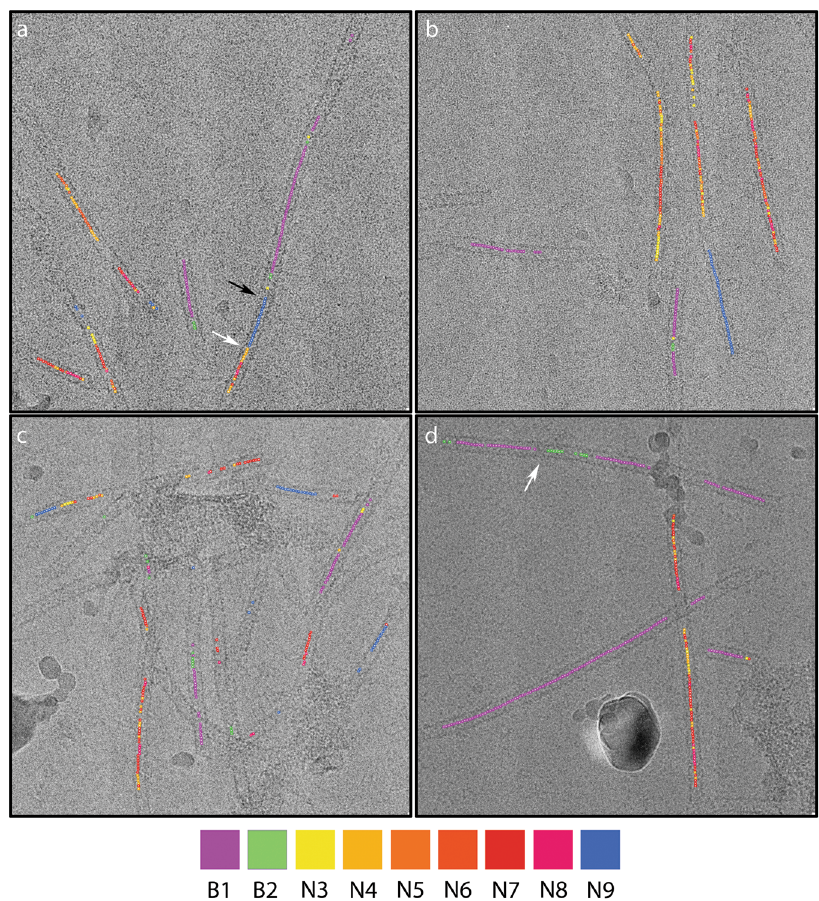
Fig. 5 Filaments annotated to show conformations. Four micrographs are shown annotated to show the position of fi bril image sections that contributed to each of the three reconstructions. This shows that fi brils may comprise regions in all three states, however, while narrow/tight-packed forms are seen to alternate along single fi brils, open forms are seen in discrete sections of longer fi brils. In general broad and narrow conformations appear to be distinct, some instances of apparent transition from one narrow to broad are seen, but are accompanied by discontinuities in the density ( a -black arrow), changes from tight to open forms are marked by the presence of constrictions ( a , d – white